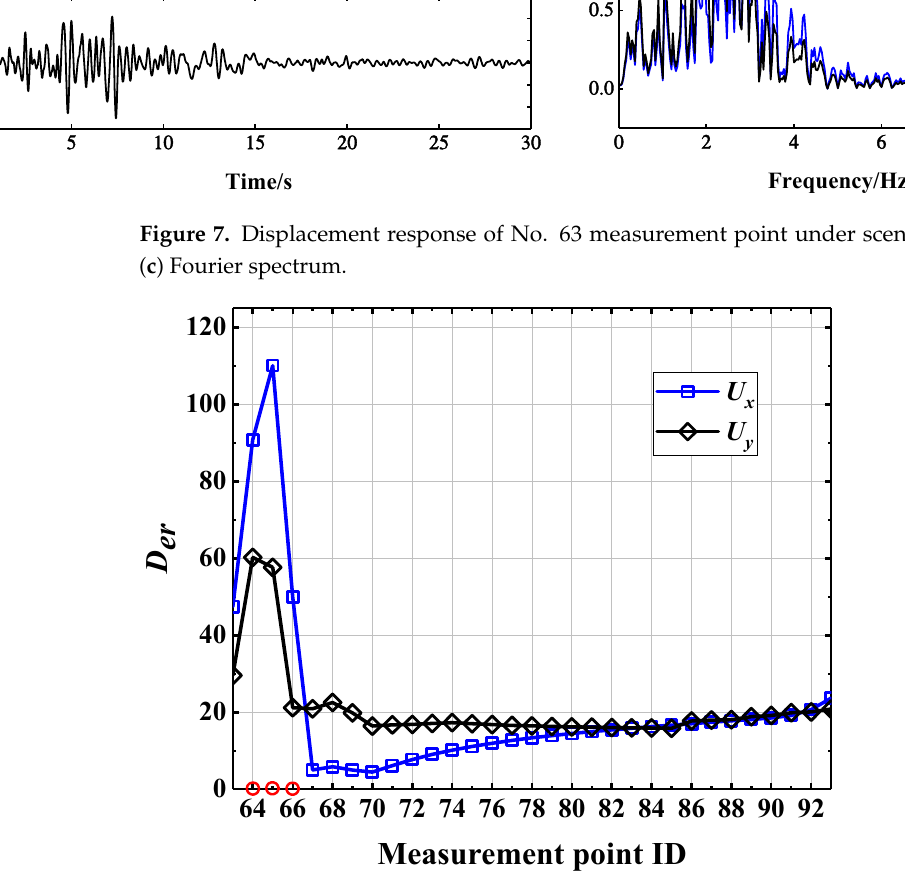
Figure 8. Comparison of U x and U y response identification results.